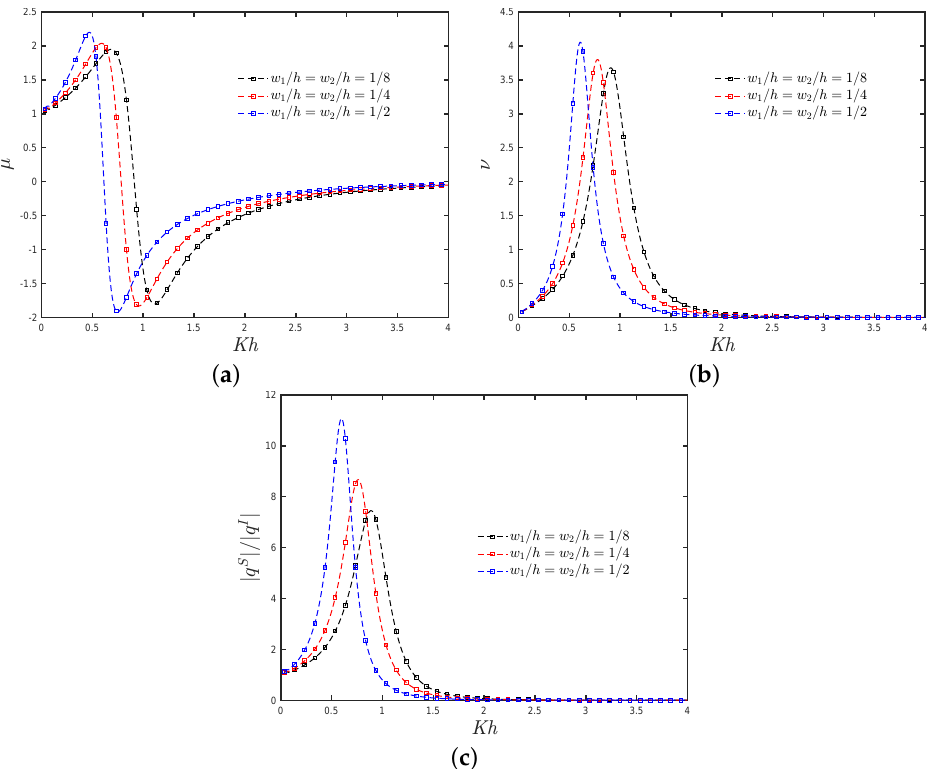
Figure 10. The influence of the thickness in the rear and front walls, w 1 / h and w 2 / h , respectively, on the ( a ) radiation susceptance coefficient, ( b ) radiation conductance coefficient and ( c ) non-dimensional induced volume flux due to the scattering potential against Kh with a 1 / h = a 2 / h = 1/2, b / h = 3/4 and h e / h = 3/4.